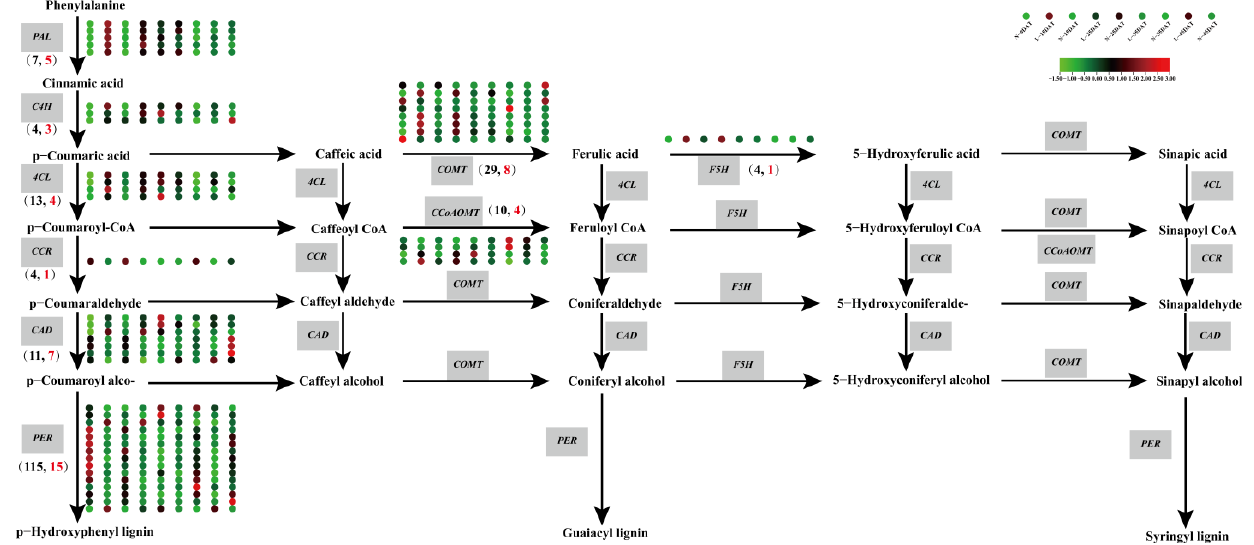
Figure 6. Lignin synthesis pathway of Chinese cabbage under low temperature. The nine circles of the heat map correspond to nine treatments. The gray boxes indicate different genes. The total number of genes in the brackets indicate black font, and the number of DEGs indicate red font.